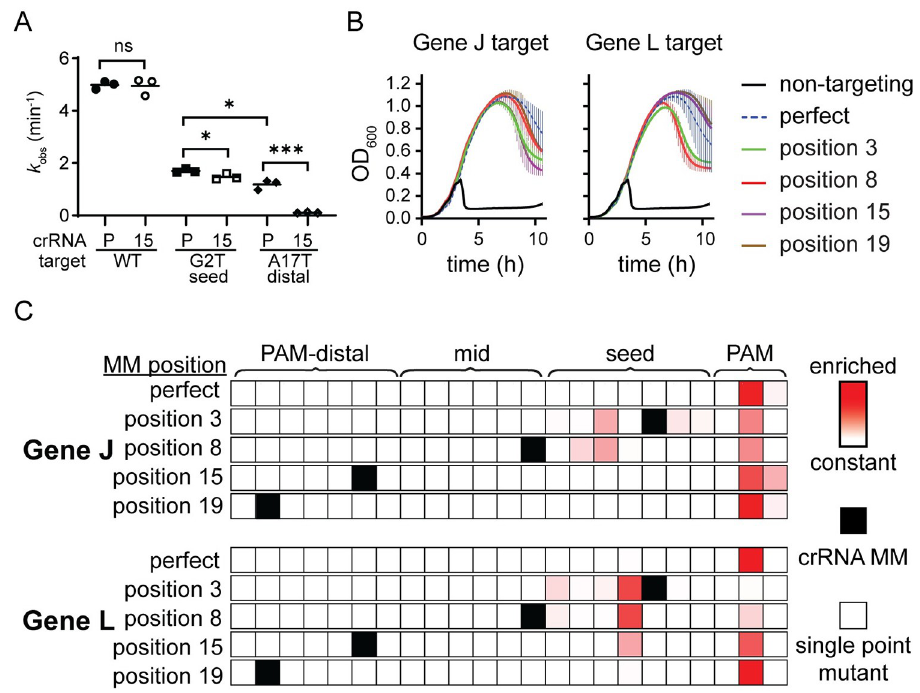
Fig 4. Cas9 challenge does not cause emergence of PAM-distal mutants. (A) Observed rate constants for cleavage of a target plasmid bearing a wild type (WT), seed mutant (G2T) and PAM-distal mutant (A17T) gene L target sequence. Cas9 cleavage was measured for both the perfectly matched crRNA (P) or the MM15 crRNA (15). Significance was tested pairwise for all crRNA/target combination by unpaired two-tailed t test. * P � 0.05, *** P � 0.001, ns P > 0.05. Pairwise comparisons for which P value are not indicated had a P < 0.0001. See S9 Fig and S1 Data for crRNA and target sequences, gels, and quantified and fit data. (B) Growth curves of E . coli expressing Cas9 and sgRNAs bearing either a non-targeting sequence, the perfectly matching spacer sequence (perfect), or a spacer containing mismatch at the indicated position with respect to the PAM. Phage was added when the cells reached mid log phase at approximately 2 h after inoculation. The average of 3 replicates is plotted for each condition, with error bars representing standard deviation. See S2 Data for quantified data. (C) Heat maps showing the location of enriched phage mutations in target regions at the 8 h time point for gene J or L targets after Cas9-mediated selection. Z-scores for abundance of single-nucleotide variants, including nucleotide identity changes or deletions, were determined for each sample relative to the non-targeted control phage population. Enriched sequences indicate high Z-scores. Z- scores range from 0 (white) to 7.0 (darkest red). See S7 Data for quantification of variant